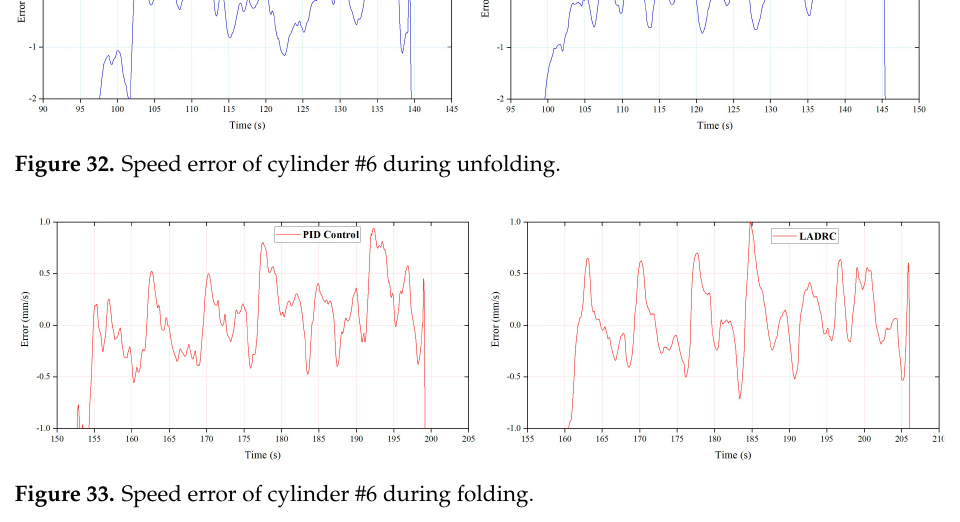
Figure 31. Step response experiment results of cylinder #6 using FLADRC. The speed error of cylinder #6 during the unfolding and folding processes using PID and FLADRC are shown in Figures 32 and 33.